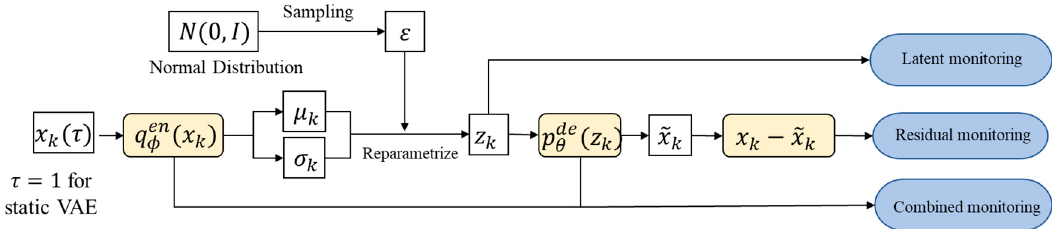
Figure 2. Fault detection flowchart.